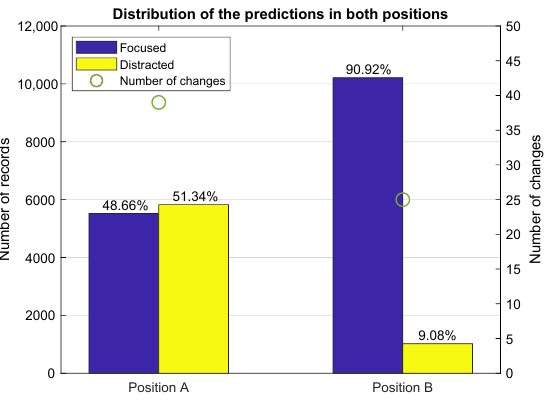
Figure 10. Obtained distribution of the predictions of the unsupervised